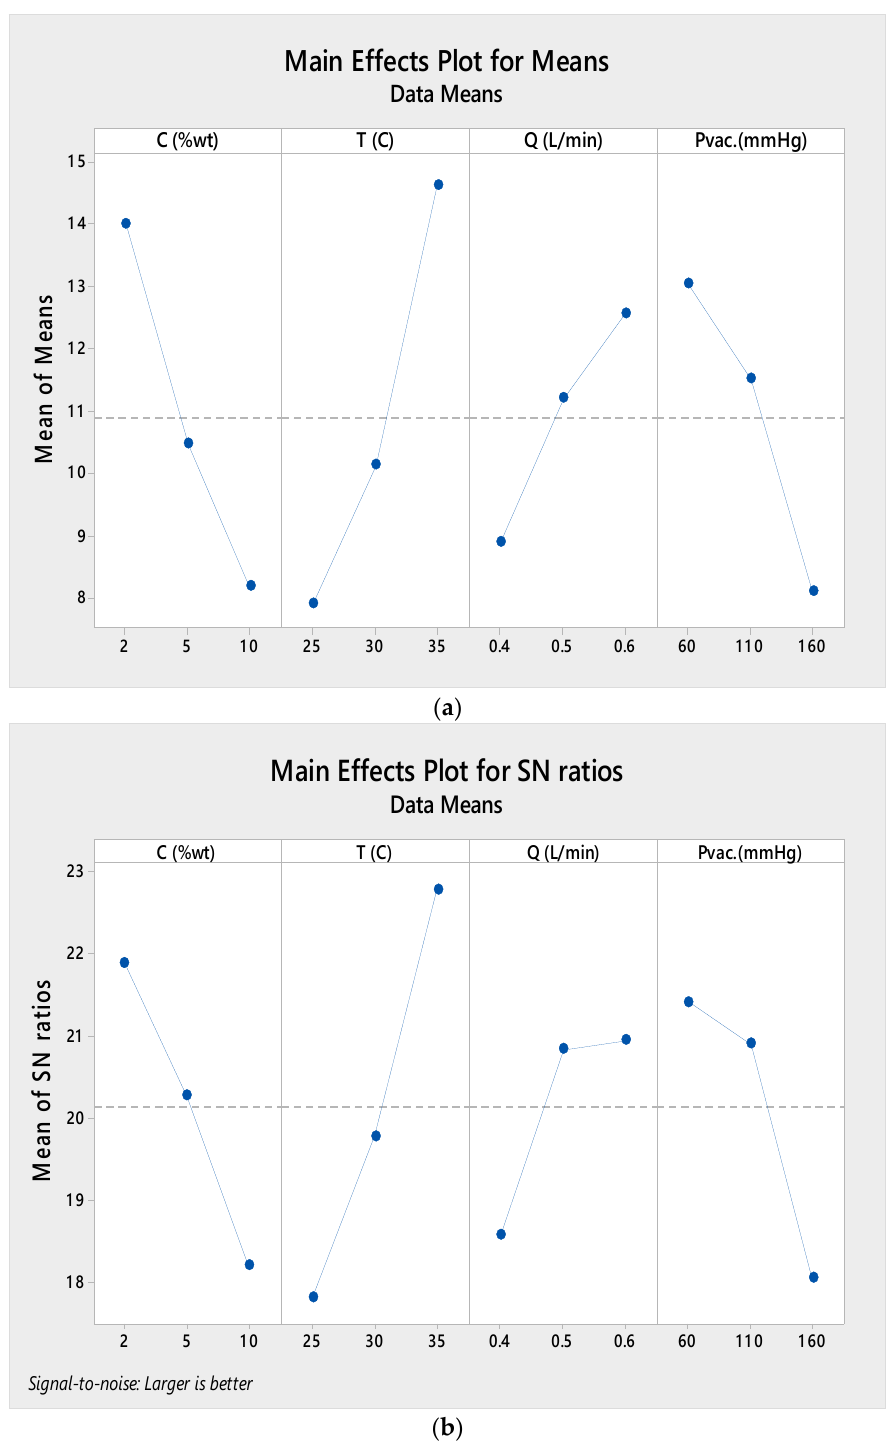
Figure 11. ( a ) VMD main-effect plot for the mean permeate flux. ( b ) VMD main-effect plot for the mean signal-to-noise ratio. Table 5. Parameters of the statistical analysis and descriptive statistics.